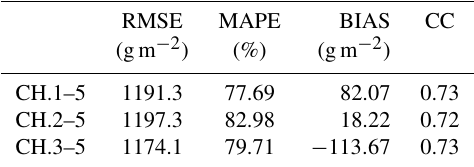
Table 6. Errors in the tropical cyclone retrieval. RMSE MAPE BIAS